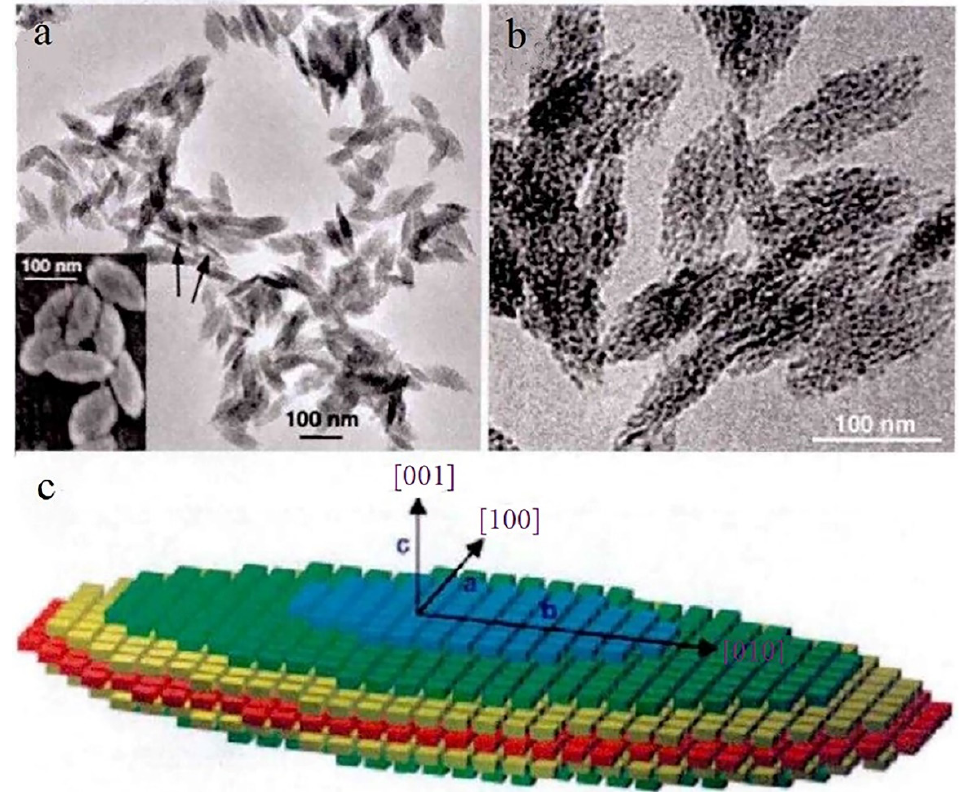
Figure 11. ( a ) An overview TEM image, ( b ) A HRTEM mage of CuO mesocrystals, ( c ) Schematic illustration of CuO mesocrystal built from aggregated nanoparticles. Arrows in ( a ) indicate ellipsoidal particles lying on their sides. The figure is reproduced with copyright permission of ref. [85].